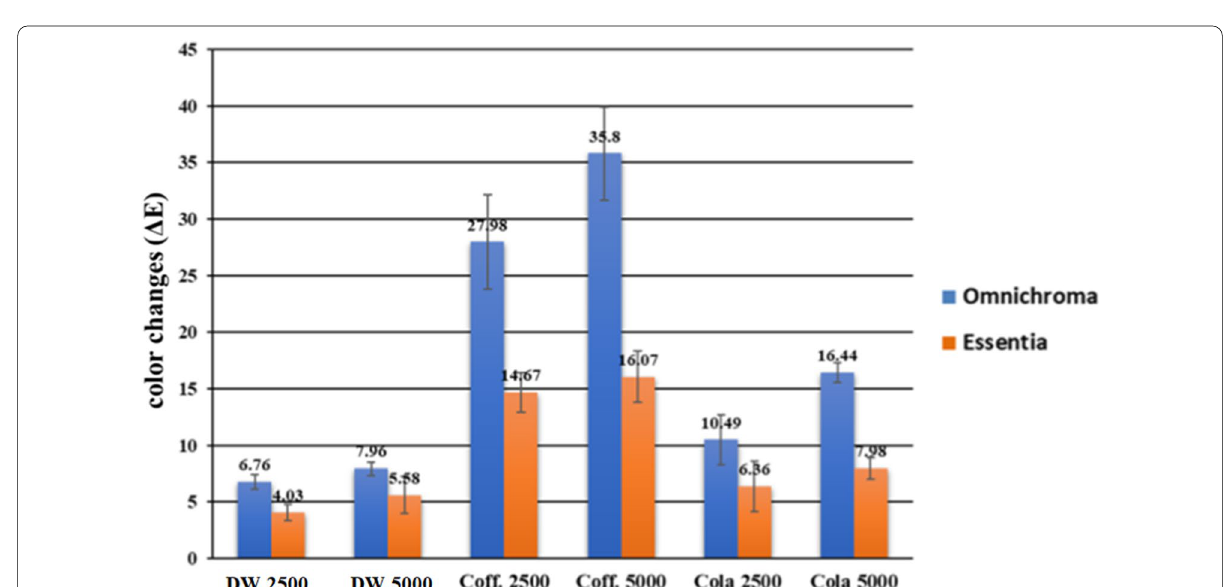
Fig. 1 The histogram showed: The change in color (ΔE) values after TC 2500 and 5000 of Omnichroma and Essentia composite